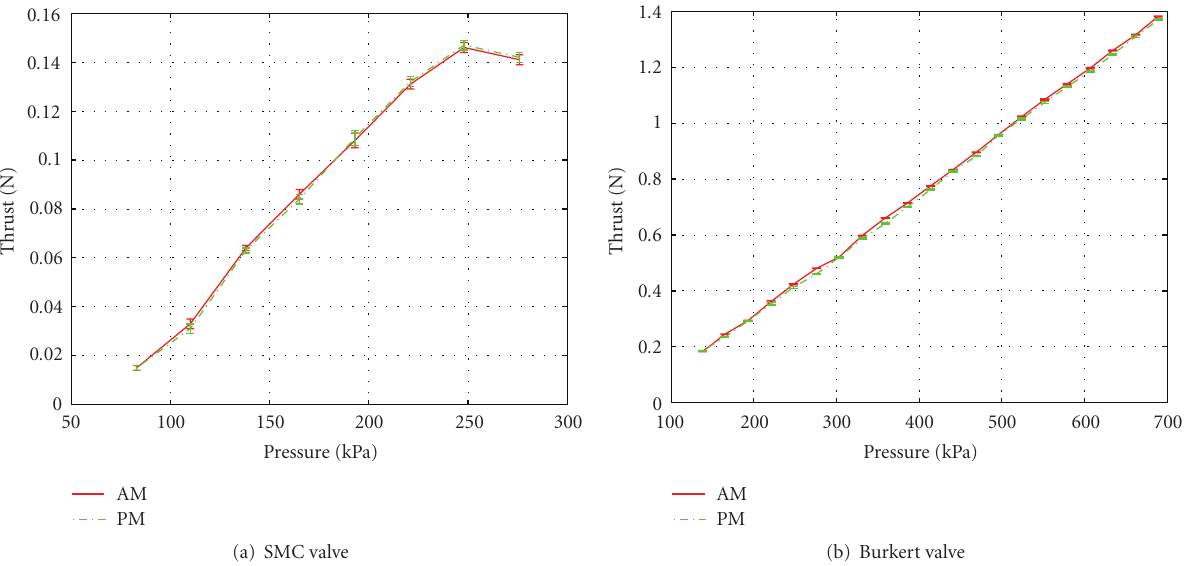
Figure 9: Thrust-pressure profile.